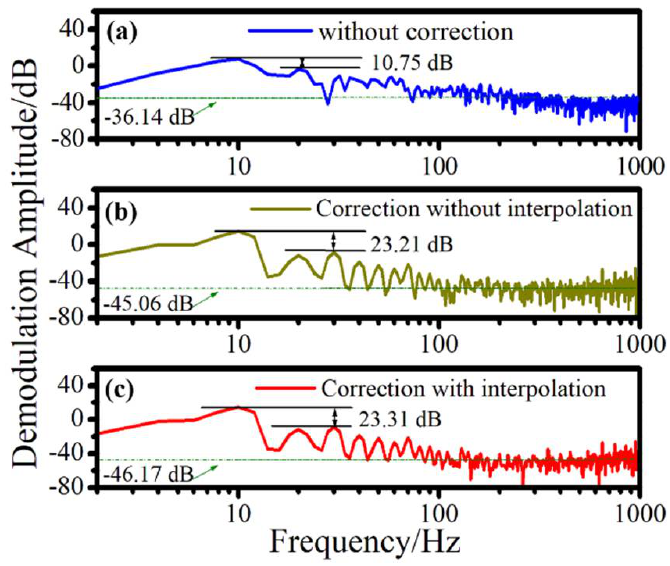
Figure 9. Comparison of PSD with different methods.